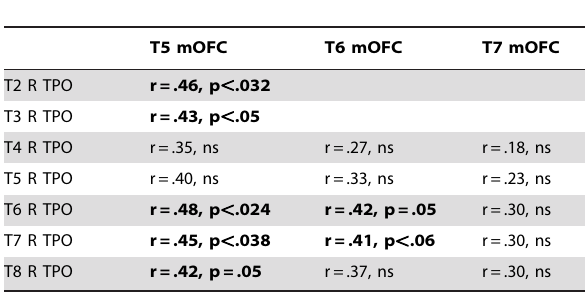
Table 2. Correlations between TPO and mOFC across